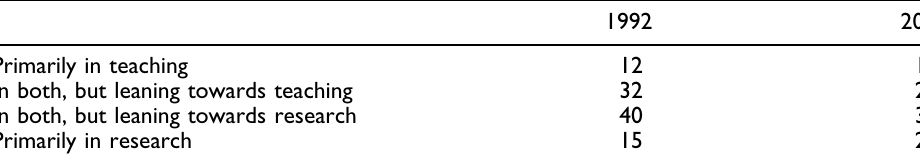
Table 2. CAP Study: primary interest (%).